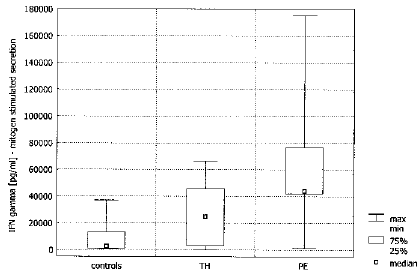
FIG. 4. Comparison of IL-10 PHA-stimulated secretion in healthy pregnant women (controls) ( n = 11), and pregnant women with transient hypertension (TH) ( n = 17) and pre- eclampsia (PE) ( n = 21). Statistically significant are the differences between controls and PE ( p < 0.002) and between TH and PE ( p < 0.008).